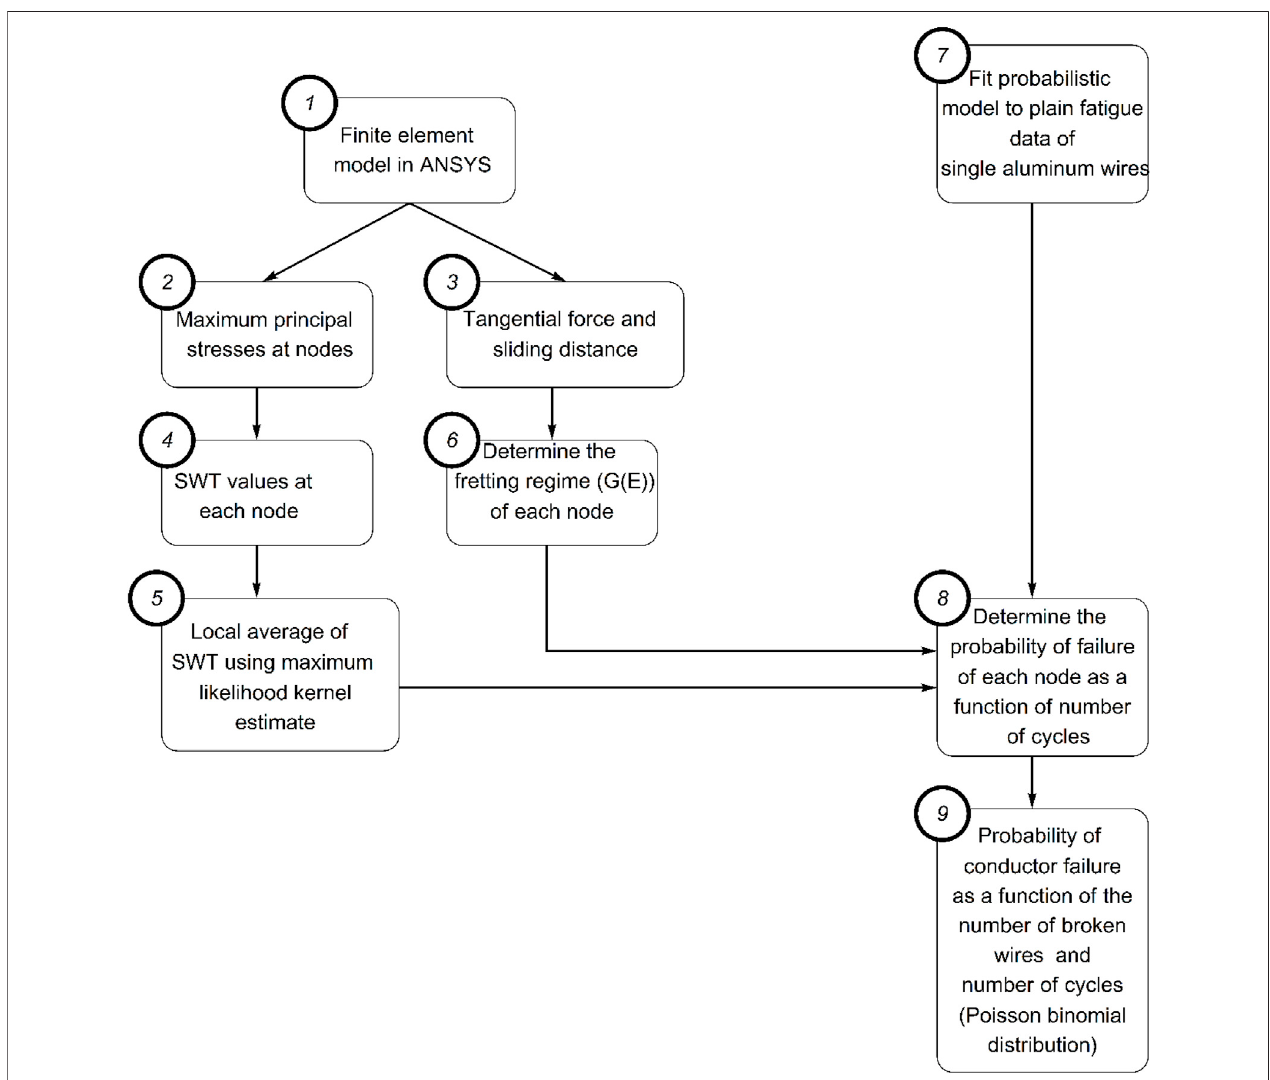
FIGURE 9 | Flow chart for developing conductor-clamp assembly fragility curve.